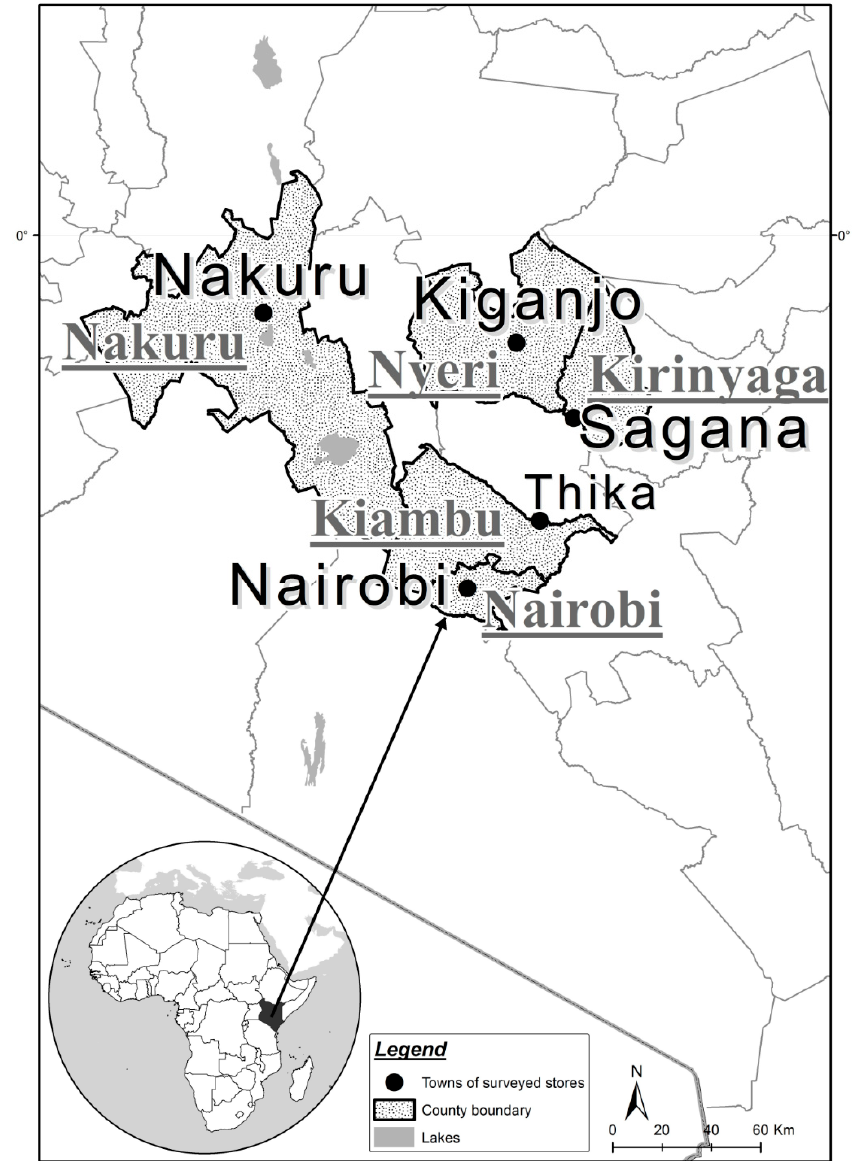
Figure 1. Locations of maize warehouses acoustically surveyed in Kenya. Names of counties are underlined.